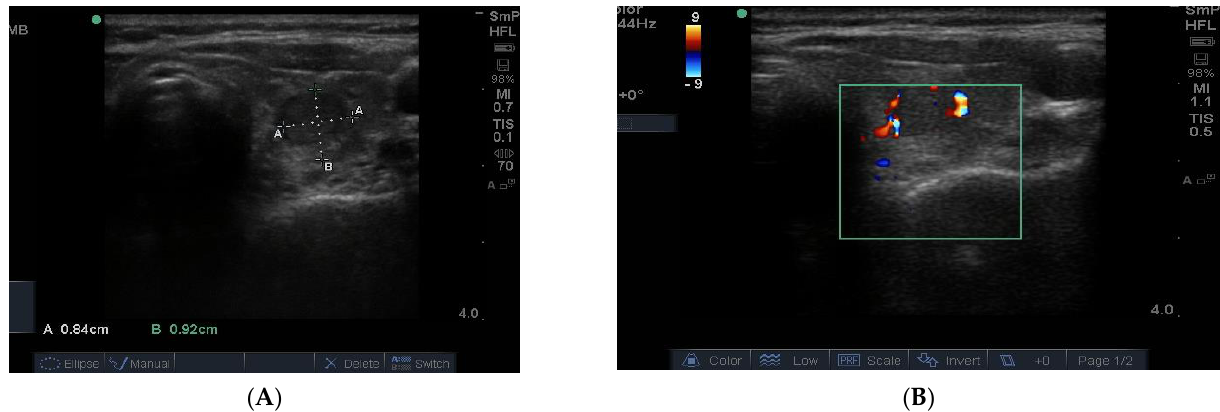
Figure 10. A small 8 mm benign nodule in the left thyroid lobe shown as an ultrasound image ( A ) and with surrounding vascularity in ( B ).